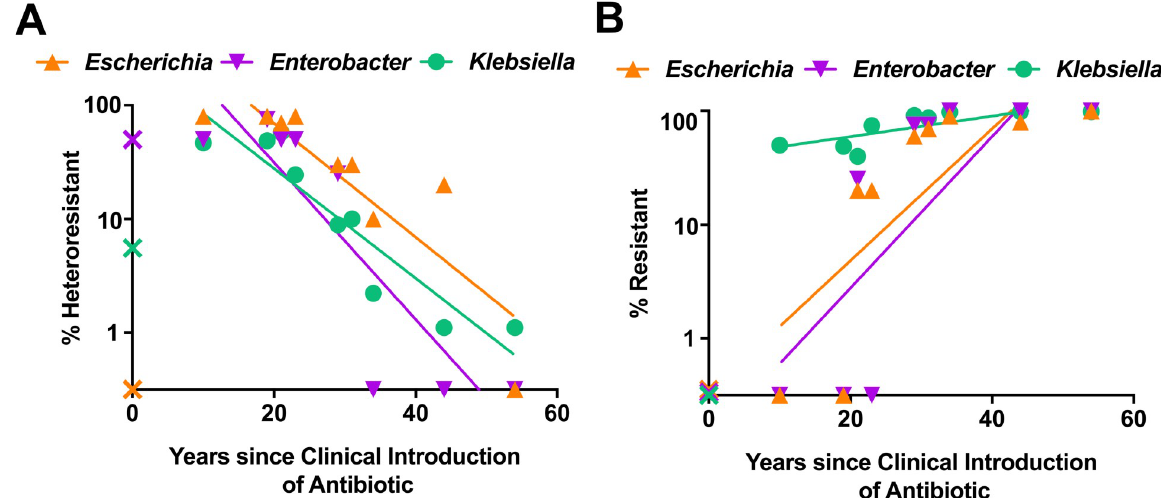
Fig 2. Incidence of resistance and heteroresistance by genus. (A, B) A total of 104 isolates of CRE from Georgia area hospitals were assayed for heteroresistance and resistance to 10 beta-lactam antibiotics and separated by genus: Escherichia ( n = 10), Enterobacter ( n = 4), and Klebsiella ( n = 90). Percent incidence of heteroresistance ( A ) and resistance ( B ) among the 3 genera is shown. Linear regressions are shown with r-squared and p -values for non-zero slope as follows: ( A , Escherichia p = 0.0023, r 2 = 0.7577; Enterobacter p = 0.0047, r 2 = 0.7608; Klebsiella p = 0.0003, r 2 = 0.8584; B , Escherichia p = 0.0162, r 2 = 0.5861; Enterobacter p = 0.0204, r 2 = 0.5598; Klebsiella p = 0.0127, r 2 = 0.6119). Ceftazidime/avibactam marked with “X” was introduced after the study isolates were collected and was not included in linear regression analysis. All data used to generate plots are available in S1 Data. CRE, carbapenem-resistant Enterobacterales.